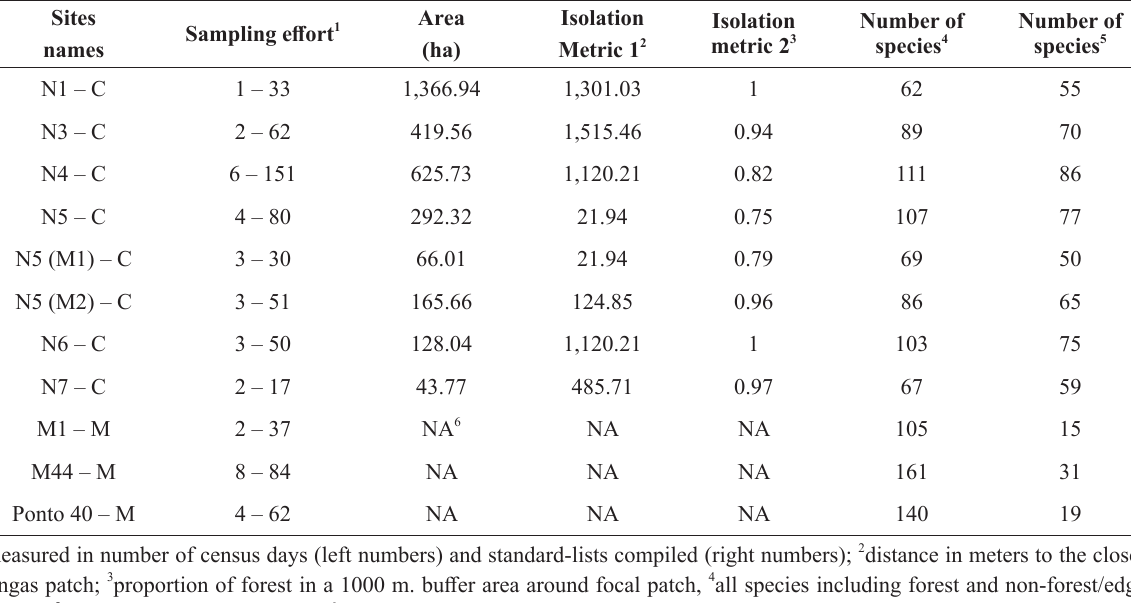
Sampling effort, characteristics of studied sites and diversity of birds in Amazonian cangas (C) and tropical forest (M) sites at Carajás National Forest.